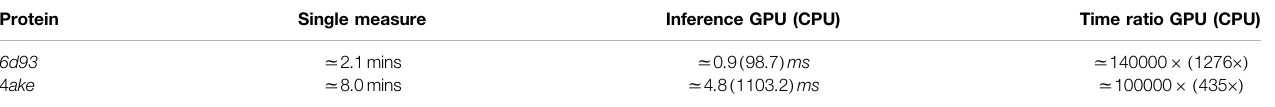
TABLE6| Comparisonbetweenthetimerequiredtocomputethe S map ofasingleCGmappingthroughthealgorithmpresented inGiulinietal.(2020)andtheinference time ofthemodel(CPU aswell asGPU).Forboth proteins, CPUcalculationswereperformedonasingle coreofaIntel Xeon-Gold 5118processor,while GPUoneswererun on a Tesla P100 with 16 GB of memory. The machine learning model generates a drastic speedup, enabling a wider exploration of the S map landscape of each system.